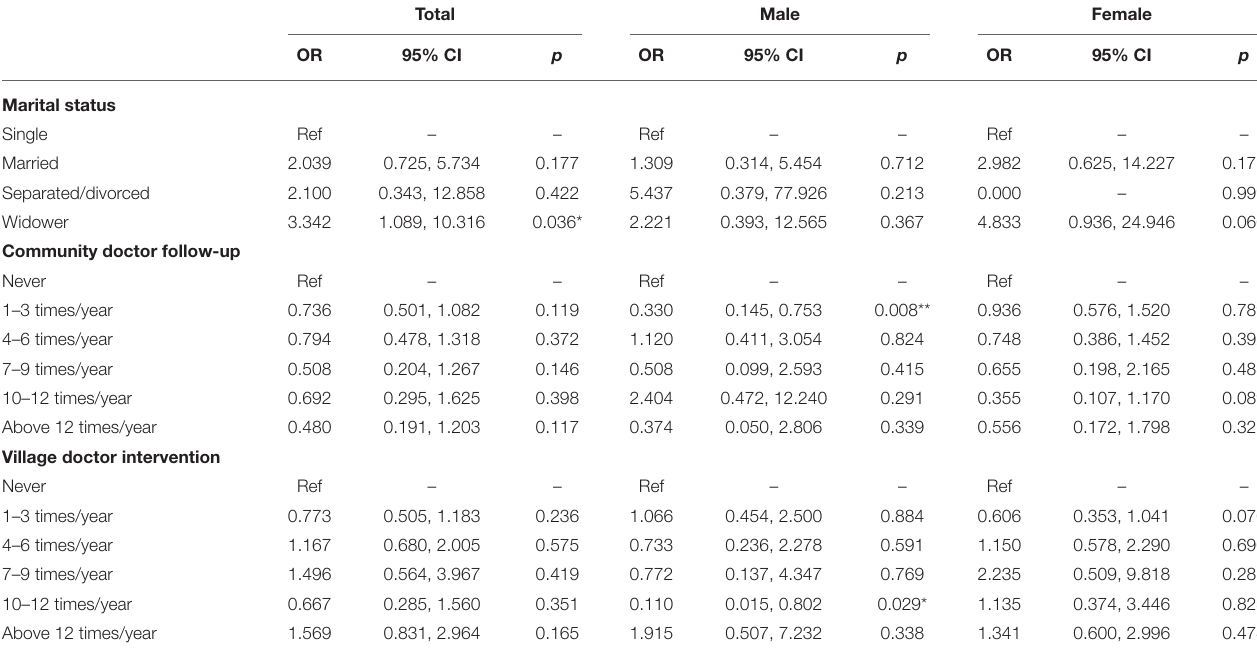
TABLE 9 | Factors contributing to multimorbidity across sex